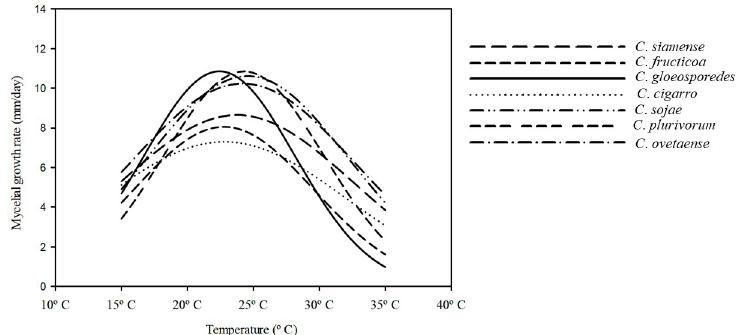
Fig 16. Effect of temperature on mycelium growth rates of Colletotrichum spp. different line type represent the mean growth rates of different species at the tested temperatures. Non-linear regression (Gaussian process) was used to determine the optimum temperature for mycelial